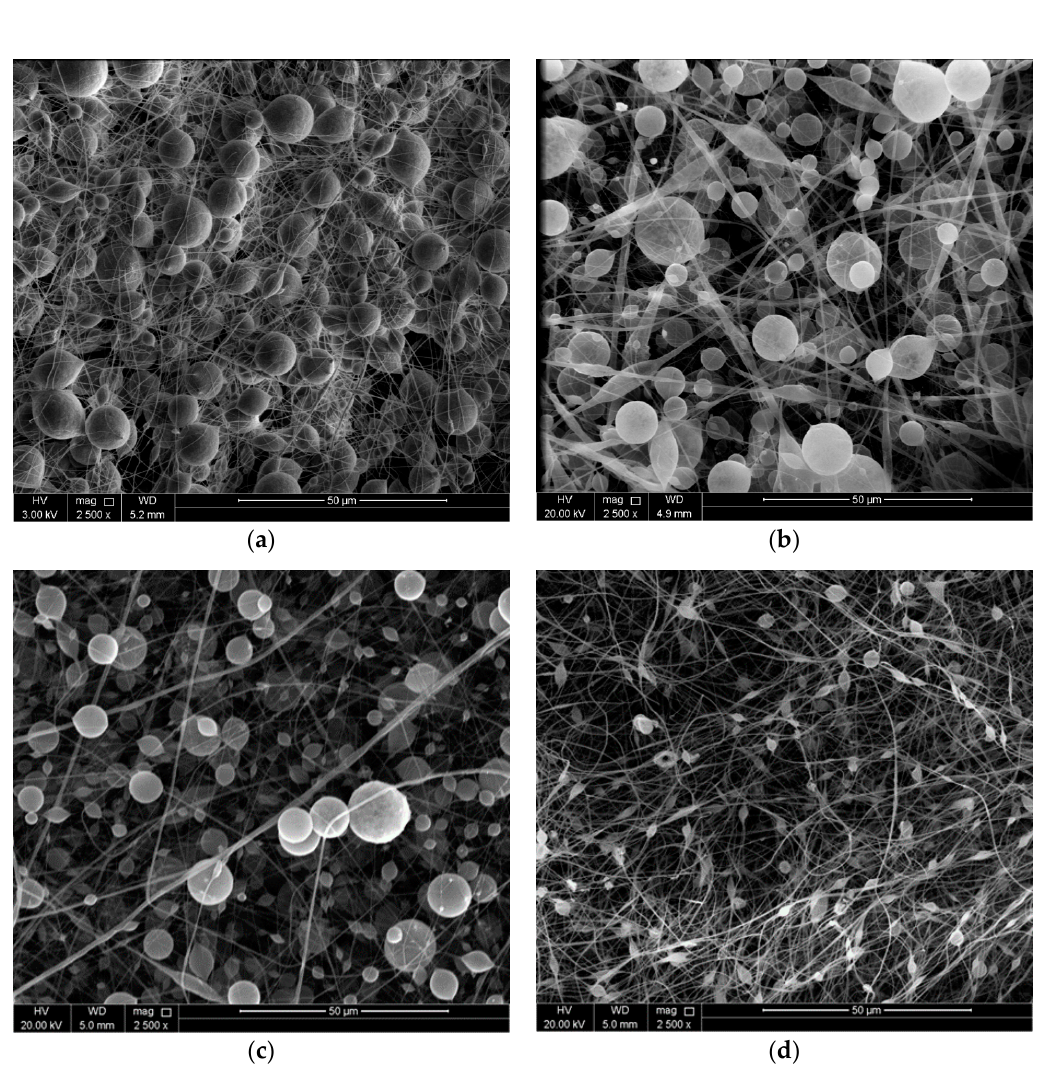
Figure 1. SEM micrographs of the as prepared PS coating without any addition of Al 2 O 3 nanoparticles for ( a ) PS1, ( b ) PS2, ( c ) PS3, and ( d ) PS4 (See Table 1 for the operational